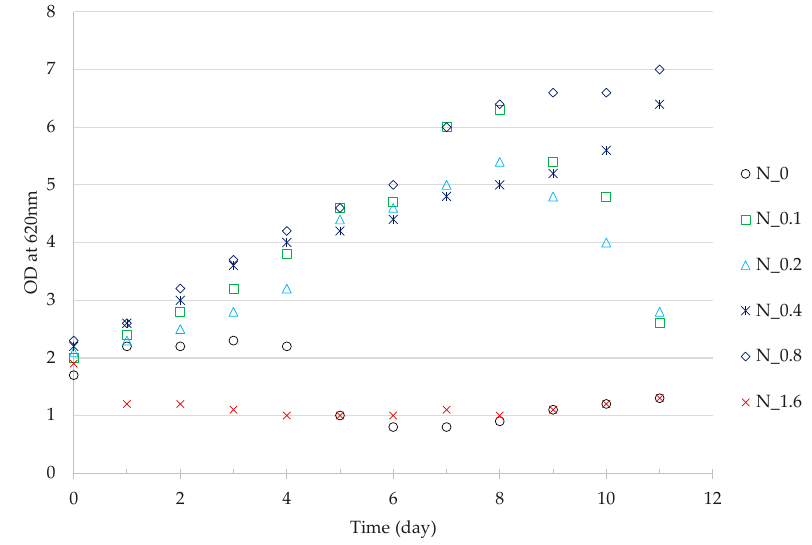
Figure 6. Chemolithotrophic growth of C. necator with different initial RCM nitrogen concentrations (0, 0.1, 0.2, 0.4, 0.8, 1.6 g N L − 1 ). Average ODs of duplicated bottle cultures are presented with the deviation less than 5%. Error bars are not plotted for clearness.